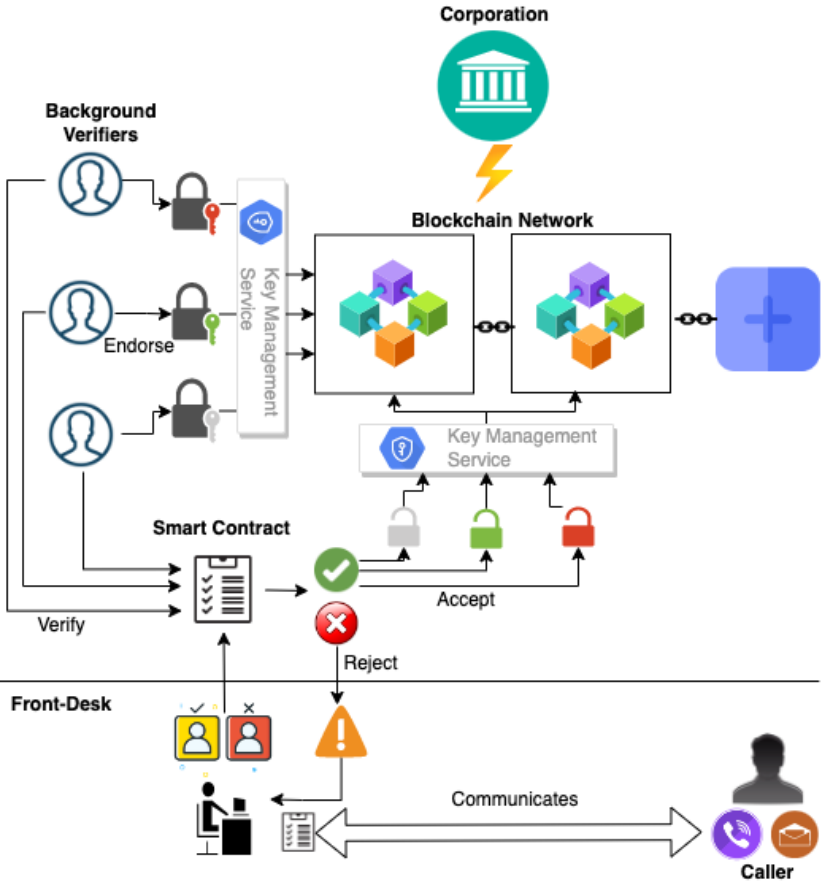
Figure 2. A blockchain-based defense model against vishing